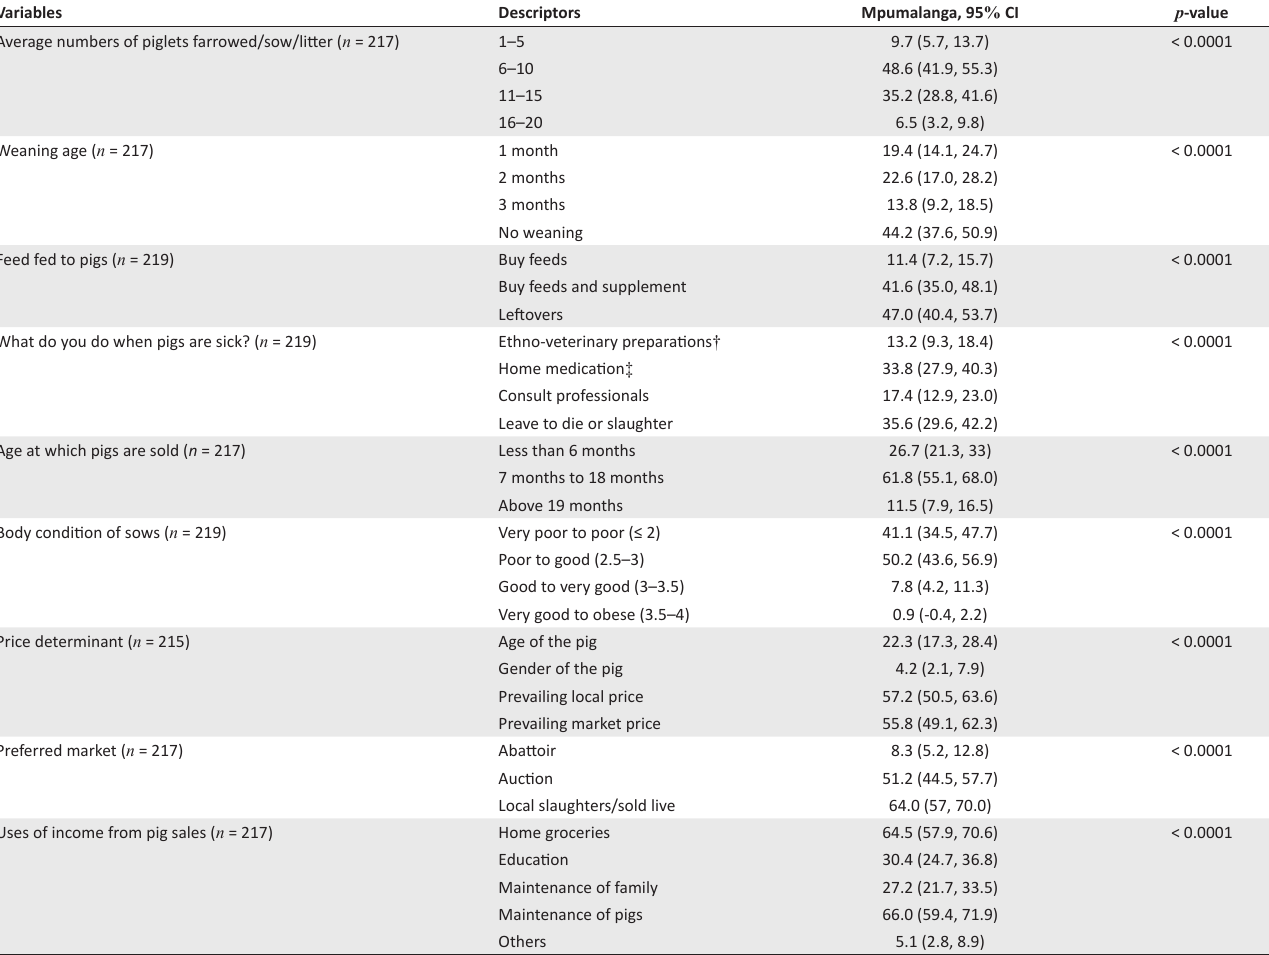
TABLE 1: Profit and market-related variables of small-holder farmers, Mpumalanga.